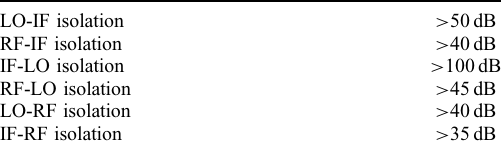
TABLE VII Isolation Between the Ports of the